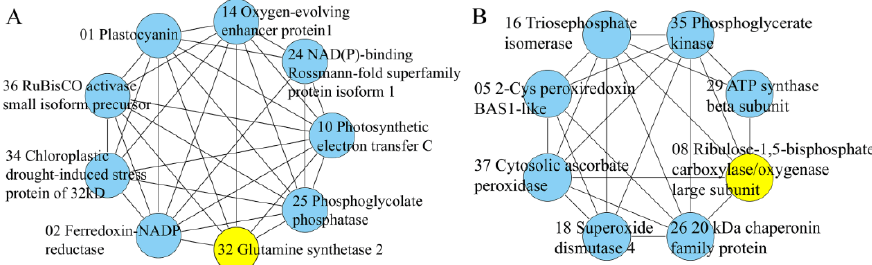
Figure 5. The two modules obtained from the protein–protein interaction network of differentially expressed proteins (DEPs). ( A ) Proteins in cluster 1 and ( B ) proteins in cluster 2.